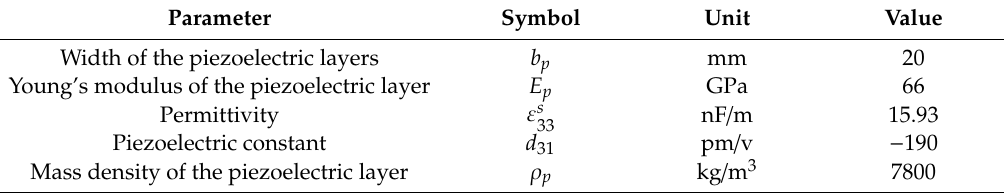
Table 5. Physical and geometrical properties of the sample piezoelectric materials.